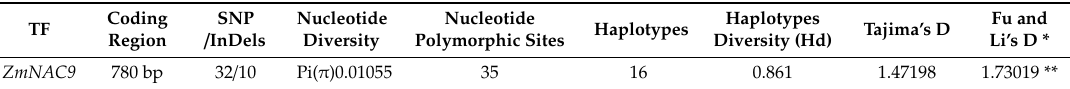
Figure 4. The nucleotide diversity π and θ value in the coding region of ZmNAC9 using the sliding windows of 100 bp with the step of 25 bp in 111 inbred lines. Table 2. Summary of single nucleotide polymorphism (SNP) sites, nucleotide diversity ( π ), nucleotide polymorphism ( θ ) and Tajima’s D, Fu and Li's D test of ZmNAC9 gene in a different maize population, and ** representing the significance value , p < 0.05.